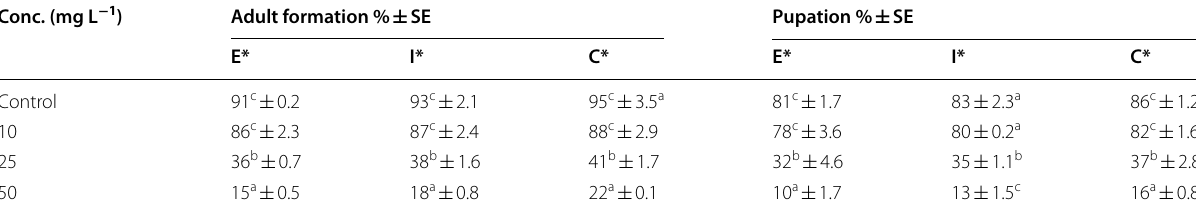
Means followed by the same letter in the same column are not significantly different according to Tukey’s multiple range test at P < 0.05 E*: Emamectin benzoate, I*: Indoxacarb, C*: